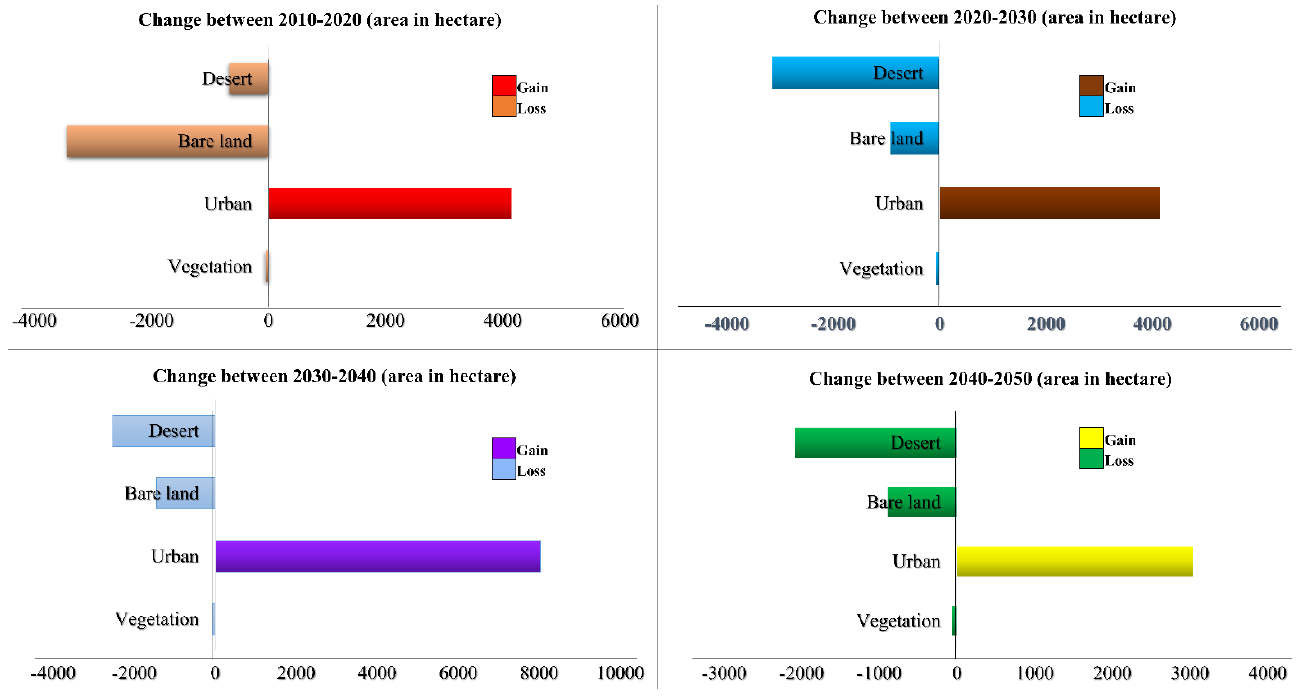
Figure 8. Gain and loss of LULC categories during observed times (2010 – 2020) and predicted years (2030 – 2050). Table 6. Changes in LULC between 2020 and 2030.